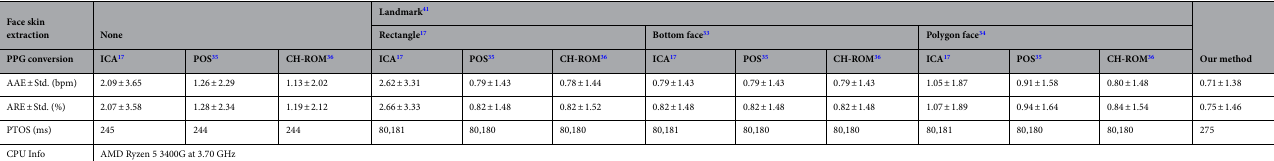
Table 2. Comparison of the performances of various methods, in terms of accuracy (AAE and ARE) and computation time (PTOS), on UBFC-RPPG (42 datasets).